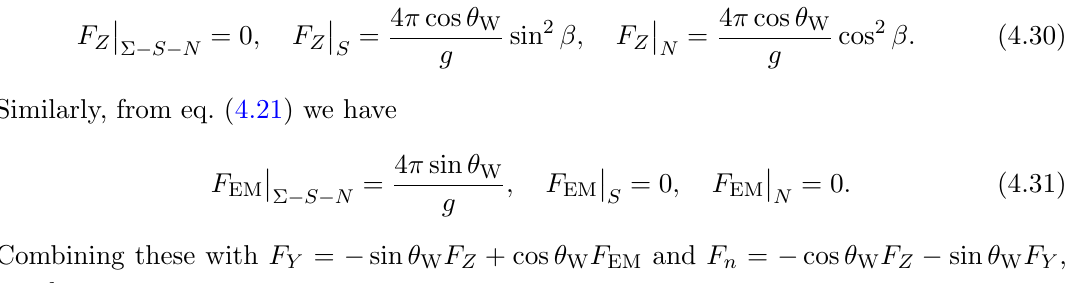
Figure 1 . The schematic pictures of the magnetic monopole in the 2HDM for tan (cid:12) 6 = 1. The (1 ; 0)-string passes through the north pole while the (0 ; 1)-string does through the south pole. respectively. Now consider a large sphere (cid:6) centered at the monopole, and let S and N be in(cid:12)nitesimally small regions at the south and north poles, respectively. Eq. (4.20)